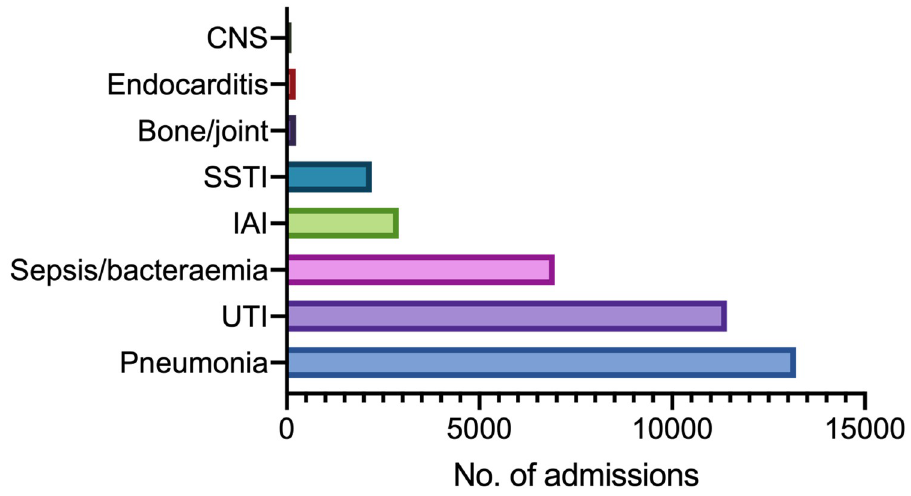
Fig 1. Number of admissions by foci of infection. Distribution of 37,298 admissions with different foci.